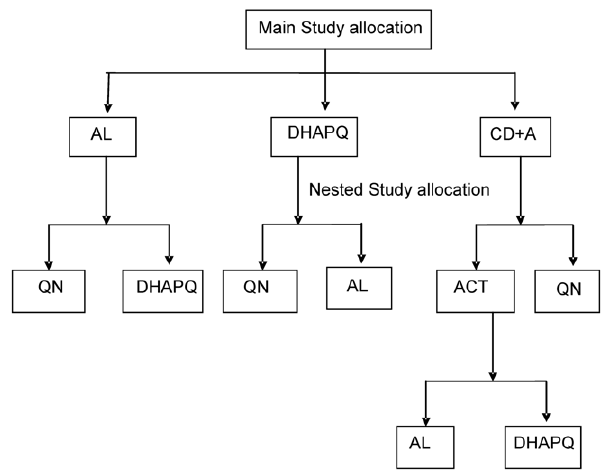
Figure 1. The study design.